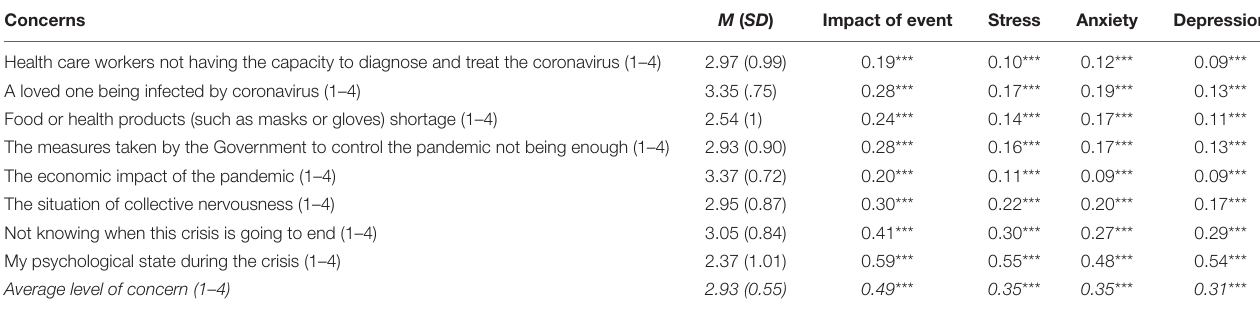
TABLE 3 | Association between types and degree of concern about the COVID-19 pandemic and the psychological impact of the COVID-19 pandemic as well as mental health status during the pandemic ( N = 3055). Concerns M ( SD ) Impact of event Stress Anxiety